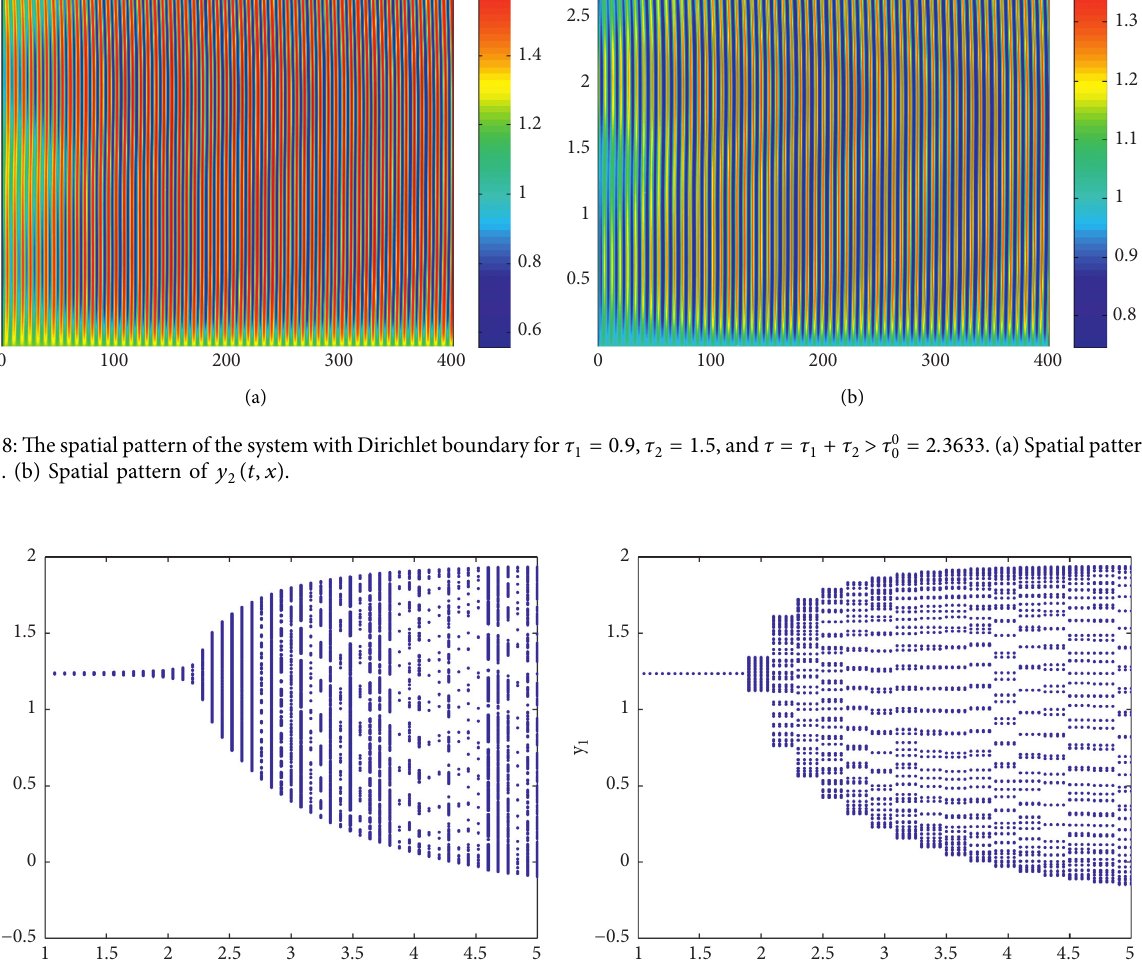
with respect to τ . (a) Without diffusion. (b) With 1